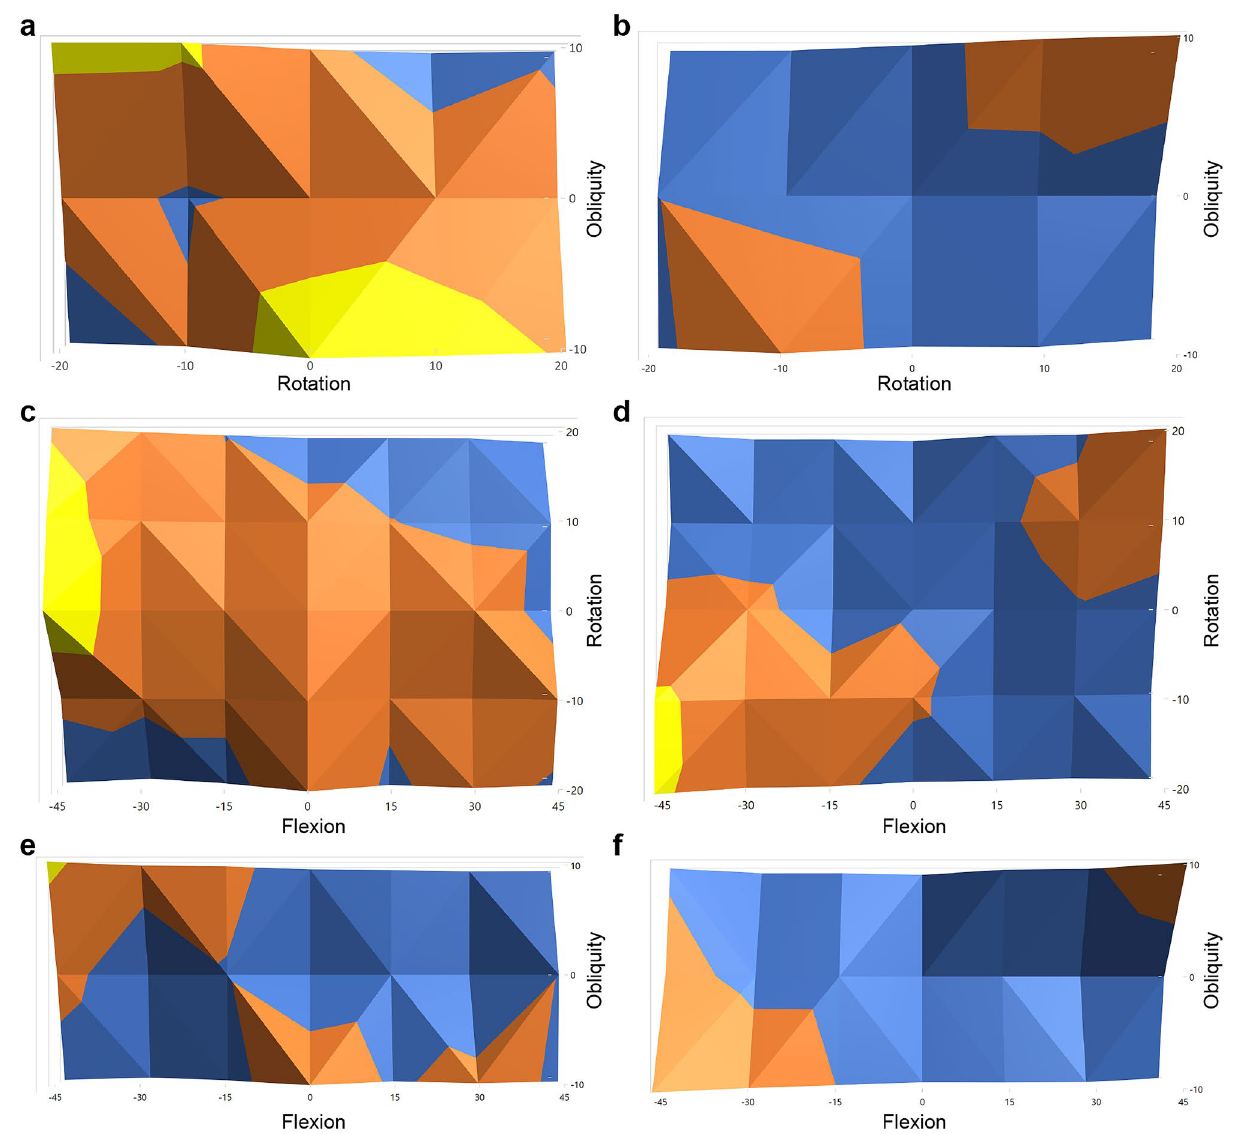
Figure 2. Heat maps for the average measurement errors of the sacral slope were drawn for positional variation in flexion, obliquity, and rotation. Blue indicates the errors in sacral slope ranging between − 7.5° and − 2.5°, scarlet indicates those between − 2.5° and 2.5°, and yellow indicates those between 2.5° and 7.5°. The average measurement errors of sacral slope are shown when the pelvis is positioned as follows: [Microsoft 365